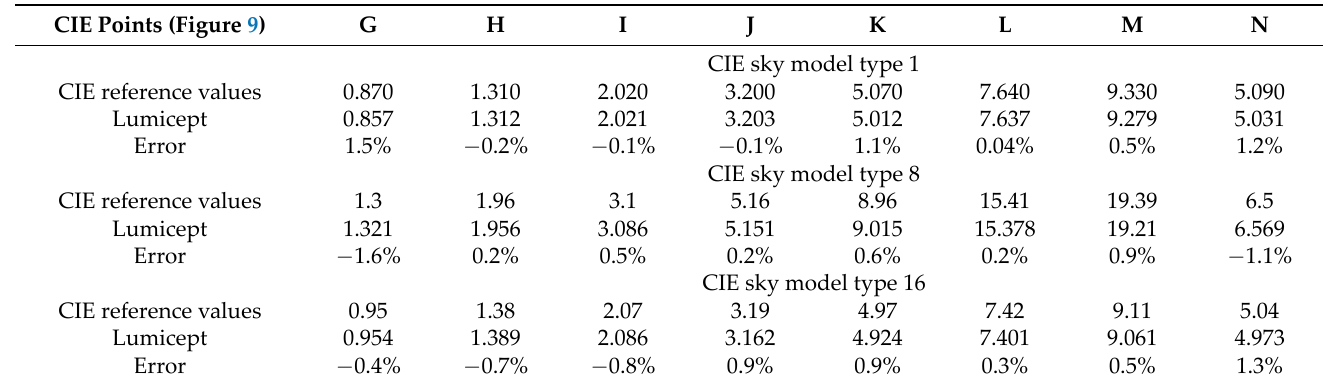
Table 9. Results of test 5.11 from CIE 171:2006. Points G–N on the floor (Figure 9).